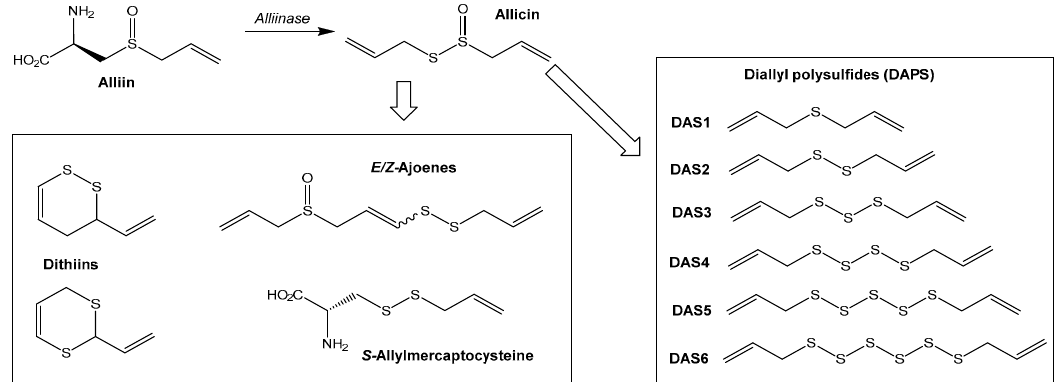
Figure 1. A summary of the key organosulfur compounds derived from garlic. Enzymatic conversion of alliin to allicin occurs immediately upon crushing of garlic. Over time, this degrades to produce an array of organosulfur compound primarily composed of dithiins, ajoenes, S -allylmercaptocysteine, and diallylpolysulfides (DAPS). Steam distillation of garlic can be used to produce garlic oils, which are mixtures of DAS1-DAS6 (note: smaller quantities of allyl/methyl mixed polysulfides are also observed in garlic oils/extracts, but their modes of action are analogous to those of DAPS) [2].